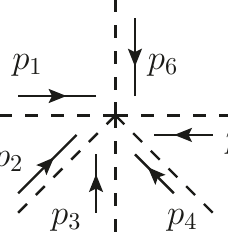
+ s 24 s 15 =P 2 + s 35 s 26 =P 2 ) =f 2 . 123 234 345